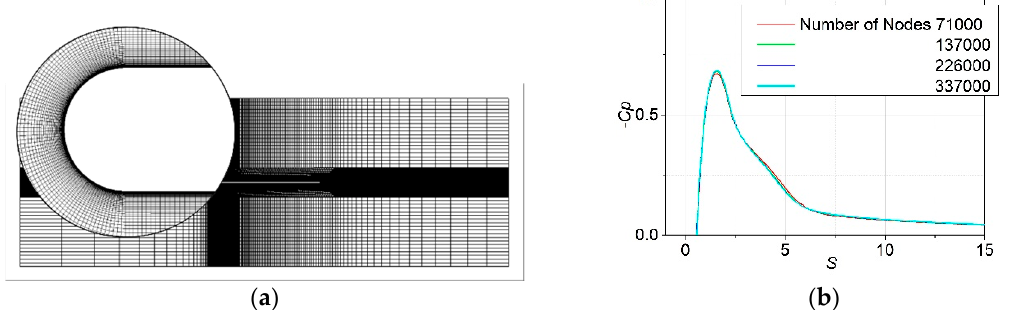
Figure 1. Mesh information: ( a ) Refinement of aerofoil computation with the local amplification of the leading edge; ( b ) Wall static pressure confidence Cp distribution of the elliptical leading edge in different mesh resolutions at Tu = 7%